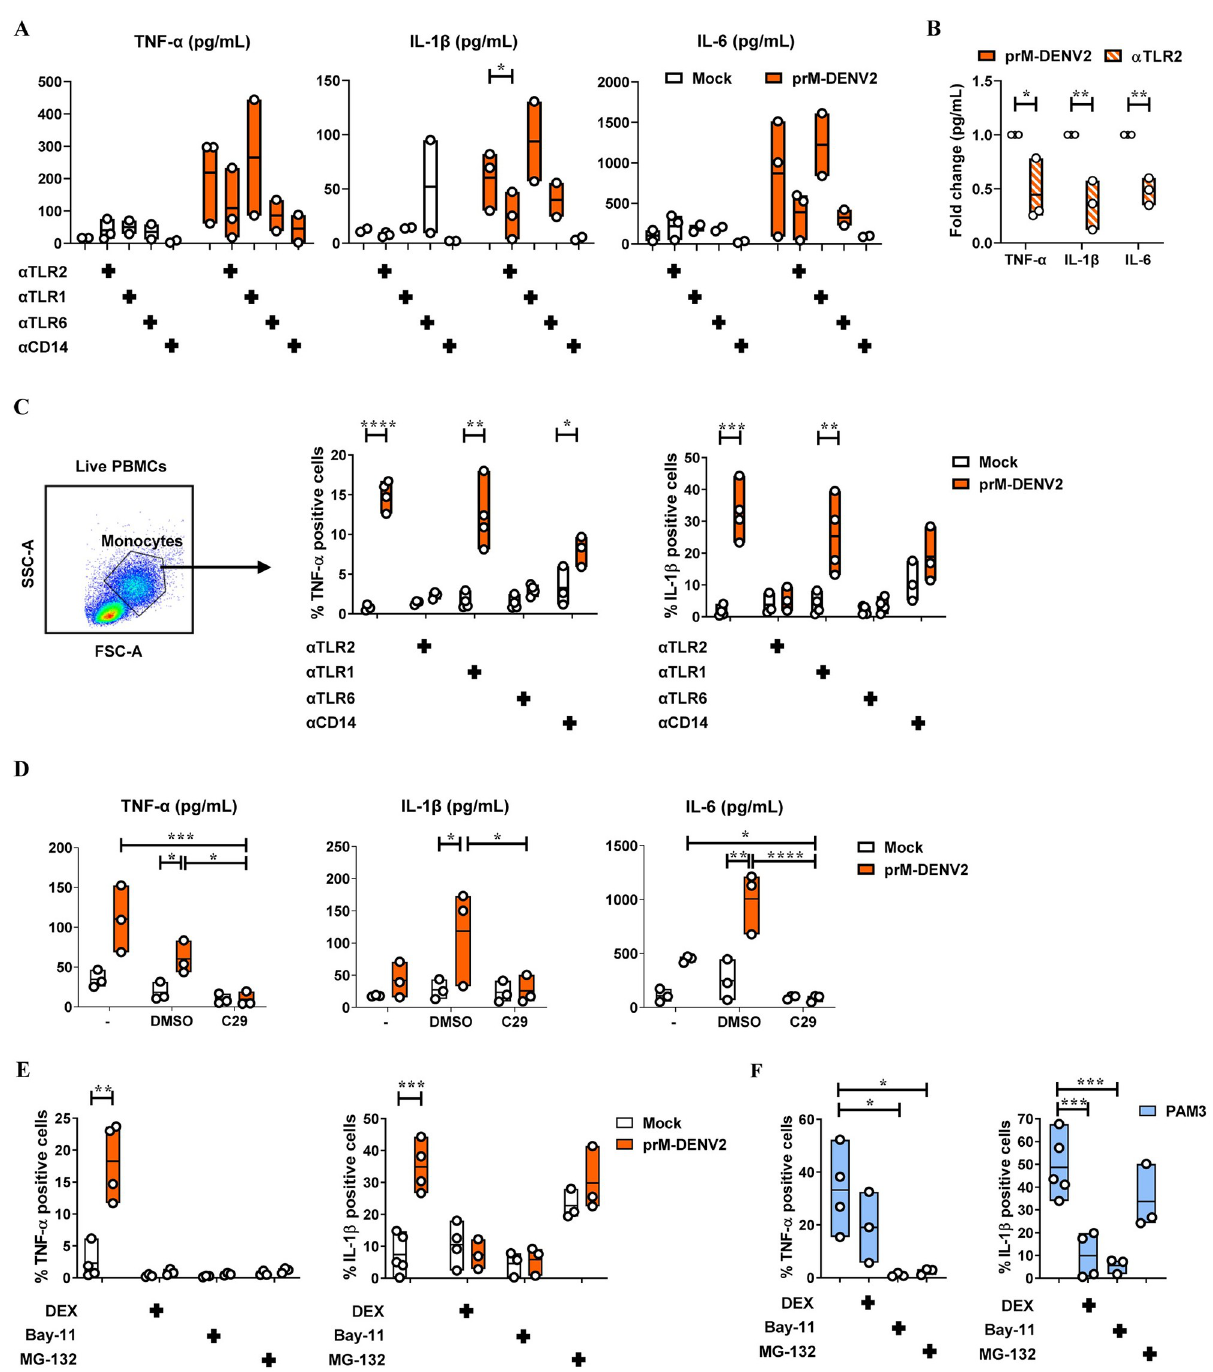
Fig 4. TNF- α - and IL-1 β intracellular accumulation induced by prM-DENV2 is TLR2/6/CD14 and NF- κ B mediated. ( A, B and D) PBMCs from healthy donors (n = 3–4, three to four different donors) were (mock) treated with α TLR2 (5 μ g/mL), α TLR1 (5 μ g/mL), TLR6 (5 μ g/mL), α CD14 (3 μ g/ mL), C29 (100 μ M) or its solvent control (DMSO) for 2 hours prior exposure with prM-DENV2 at MOG 300 for 6h. Cytokine production (in picograms per milliliter (pg/mL)) in the PBMCs’ supernatants was measured by flow cytometry using LegendPlex. ( C, E and F ) PBMCs from healthy donors (n = 3–5, three to five different donors) were (mock) treated with α TLR2 (5 μ g/mL), α TLR1 (5 μ g/mL), TLR6 (5 μ g/mL), α CD14 (3 μ g/mL), DEX, (10 μ M), Bay-11 (5 μ M) and MG-132 (9.5 μ g/mL) for 2 hours prior exposure with prM-DENV2 at MOG 300 or PAM3CSK4 (PAM3, 600 ng/mL) for 12h in the presence of Brefeldin-A. ( C , E and F ) Percentage of monocytes (in PBMCs) with intracellular expression of TNF- α and IL-1 β was measured by flow cytometry. P values were obtained by unpaired one-tailed t test. ( � P < 0.05, �� P < 0.01, ��� P < 0.001, ���� P < 0.0001).